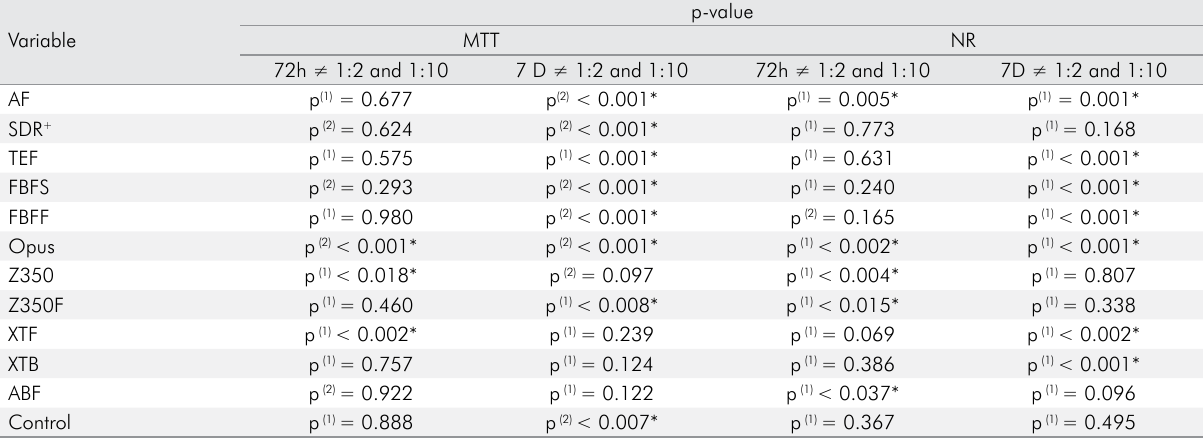
Table 4. Statistical analysis of cytotoxicity of the materials with comparison of extract concentrations, according to each test. Variable